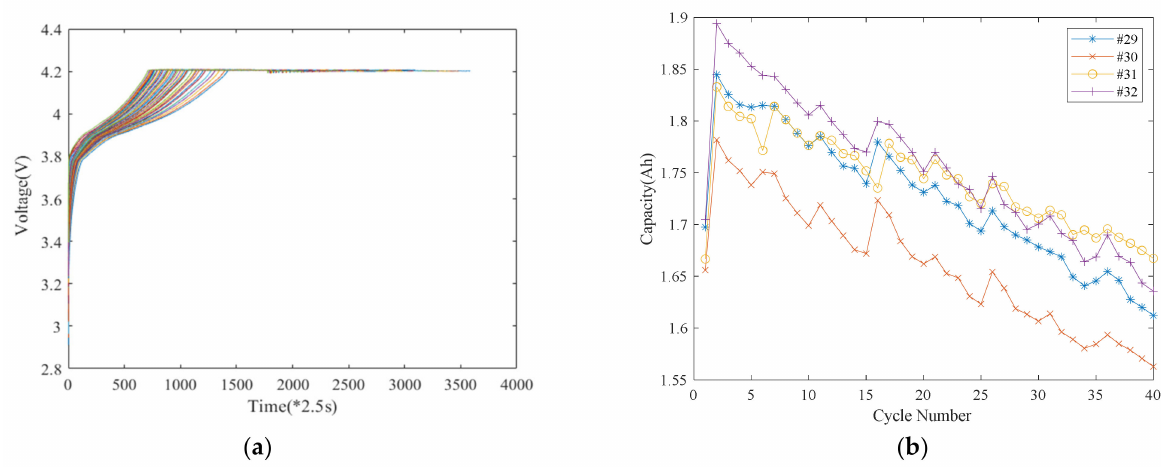
Figure 1. ( a ) CC-CV charging curve; ( b ) discharging